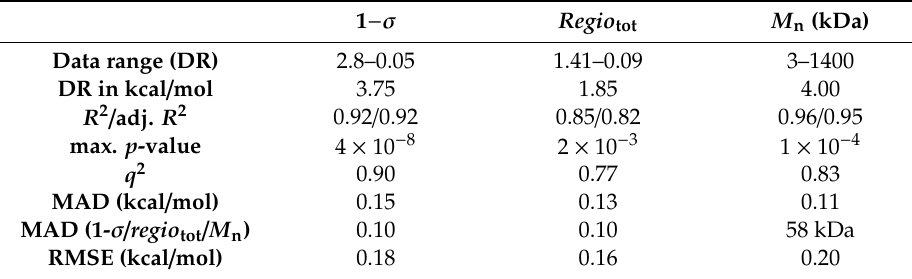
Table 6. Key QSAR model assessment criteria.